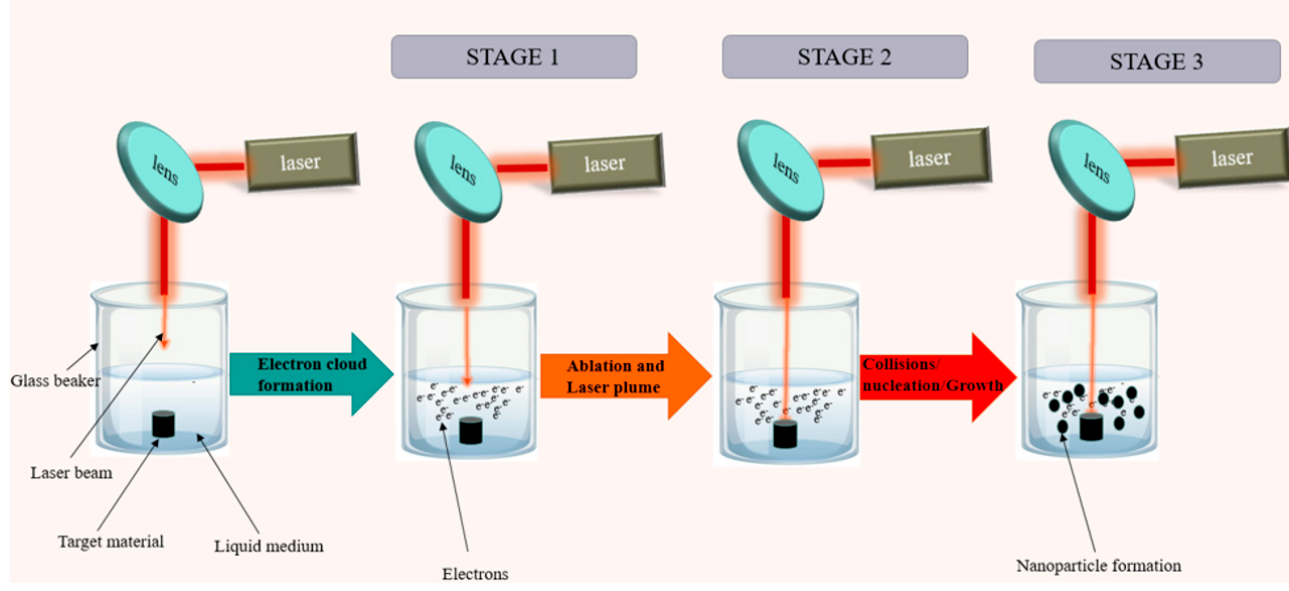
Figure 1. Illustration of the PLAL process in batch mode showing the 3 main stages of PLAL [29].